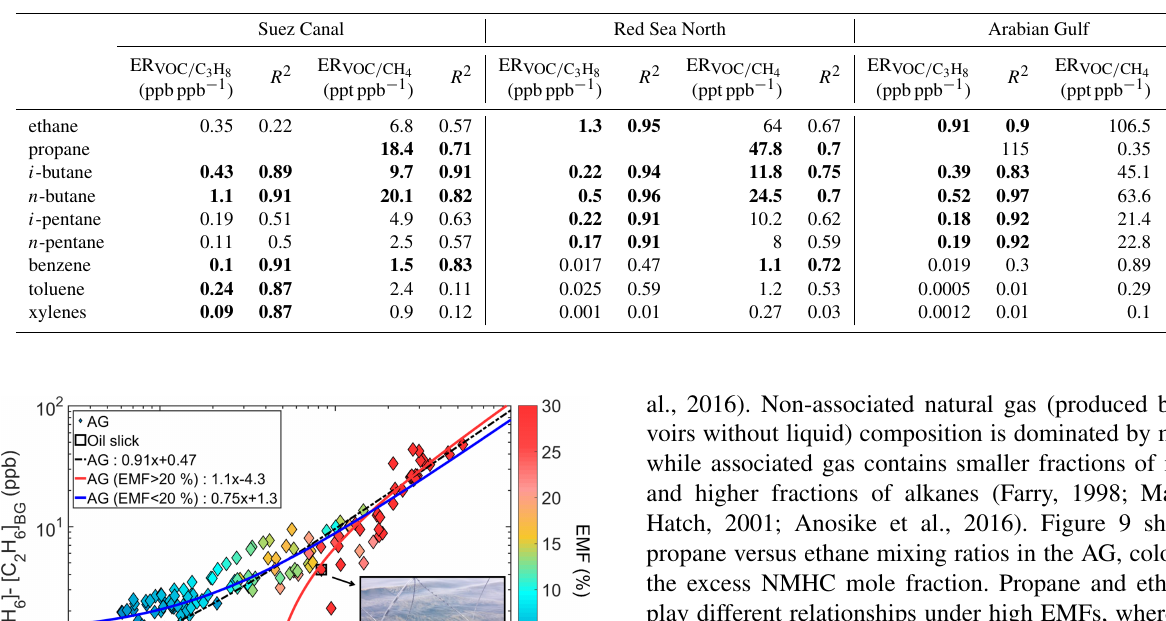
Table 3. Correlation matrix of enhancement volume mixing ratio slopes for selected alkanes and aromatics with propane and methane mixing ratios. Bold values indicate correlations with R 2 > 0 . 7.